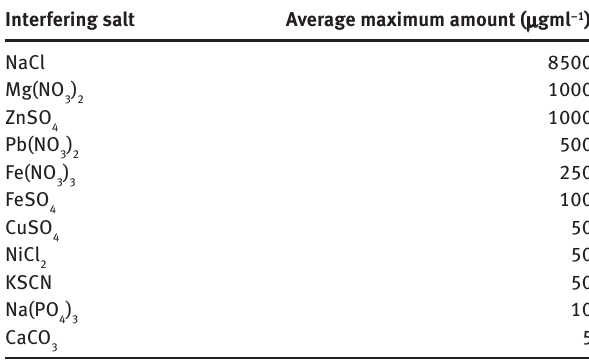
Table 3: Effect of common interfering ions on the determination of (1 μ gml − 1 ) nitrite using the proposed